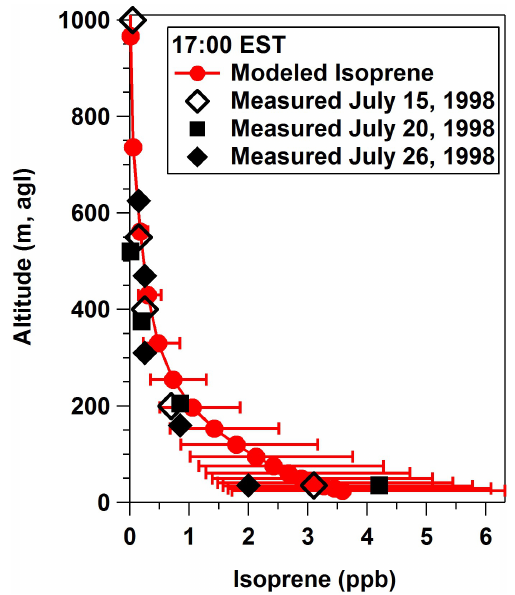
Fig. 1. Comparison of modeled and measured (Hurst et al., 2001) vertical profiles of isoprene concentrations at UMBS. Error bars represent sensitivity to the range of isoprene emission rates.